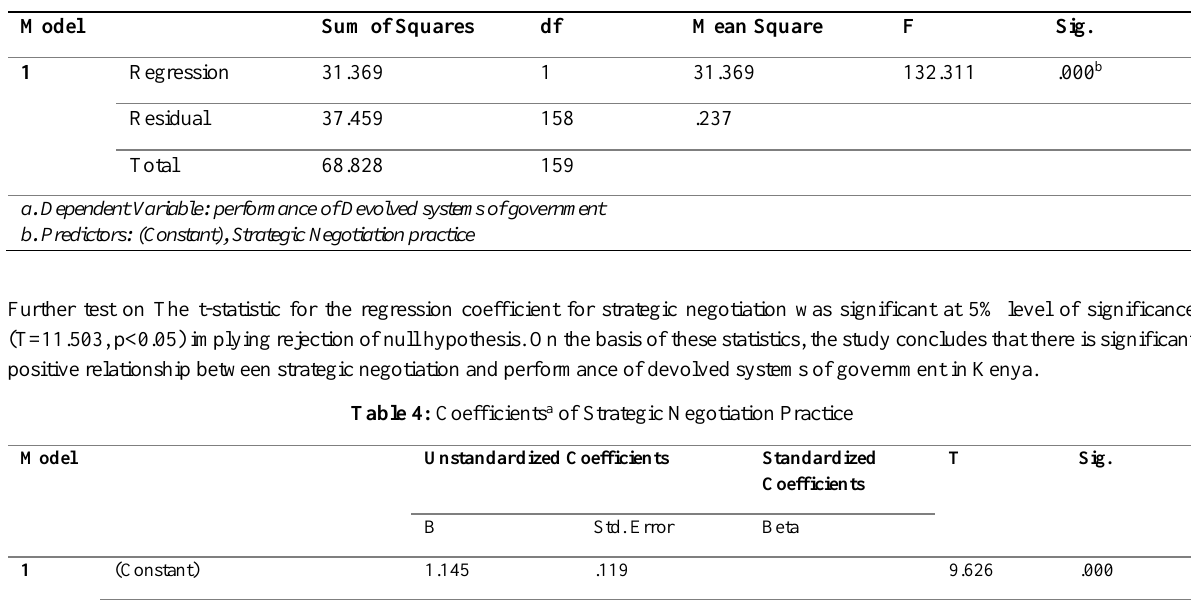
Table 3: ANOVA a of Strategic Negotiation Practice